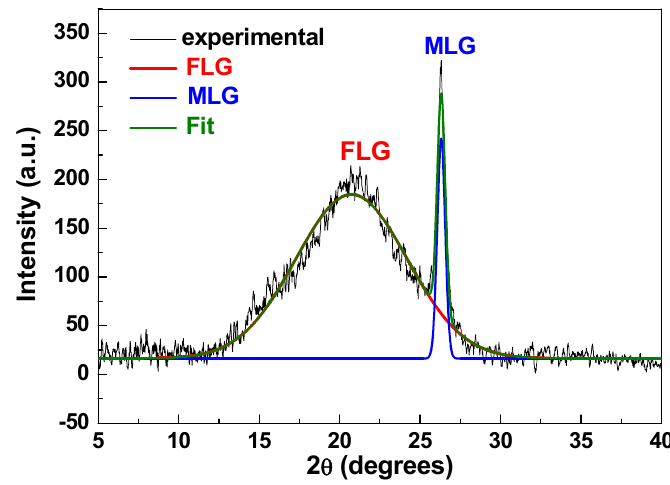
Figure 2. The XRD pattern of graphene showing the FLG and MLG peaks. Table 1. The XRD parameters associated to Gr-exf material.